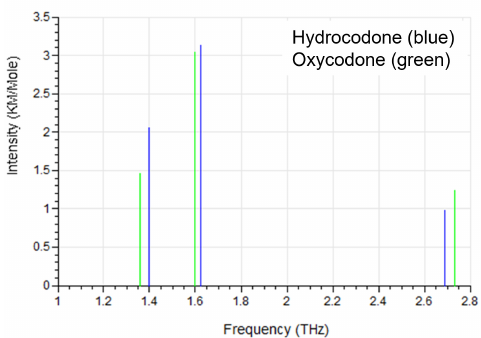
Figure 3. Absorption lines for oxycodone and hydrocodone.